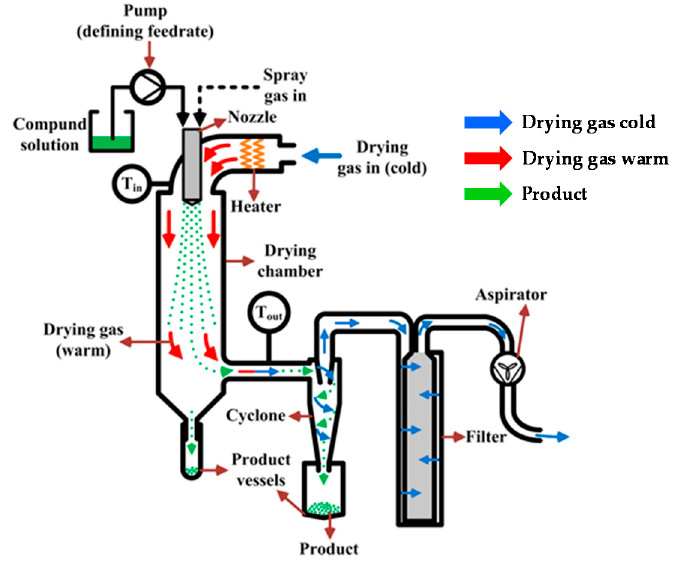
Figure 1. Schematic representation of the conventional spray-drying process. Buchi Labortechnik AG, [28].